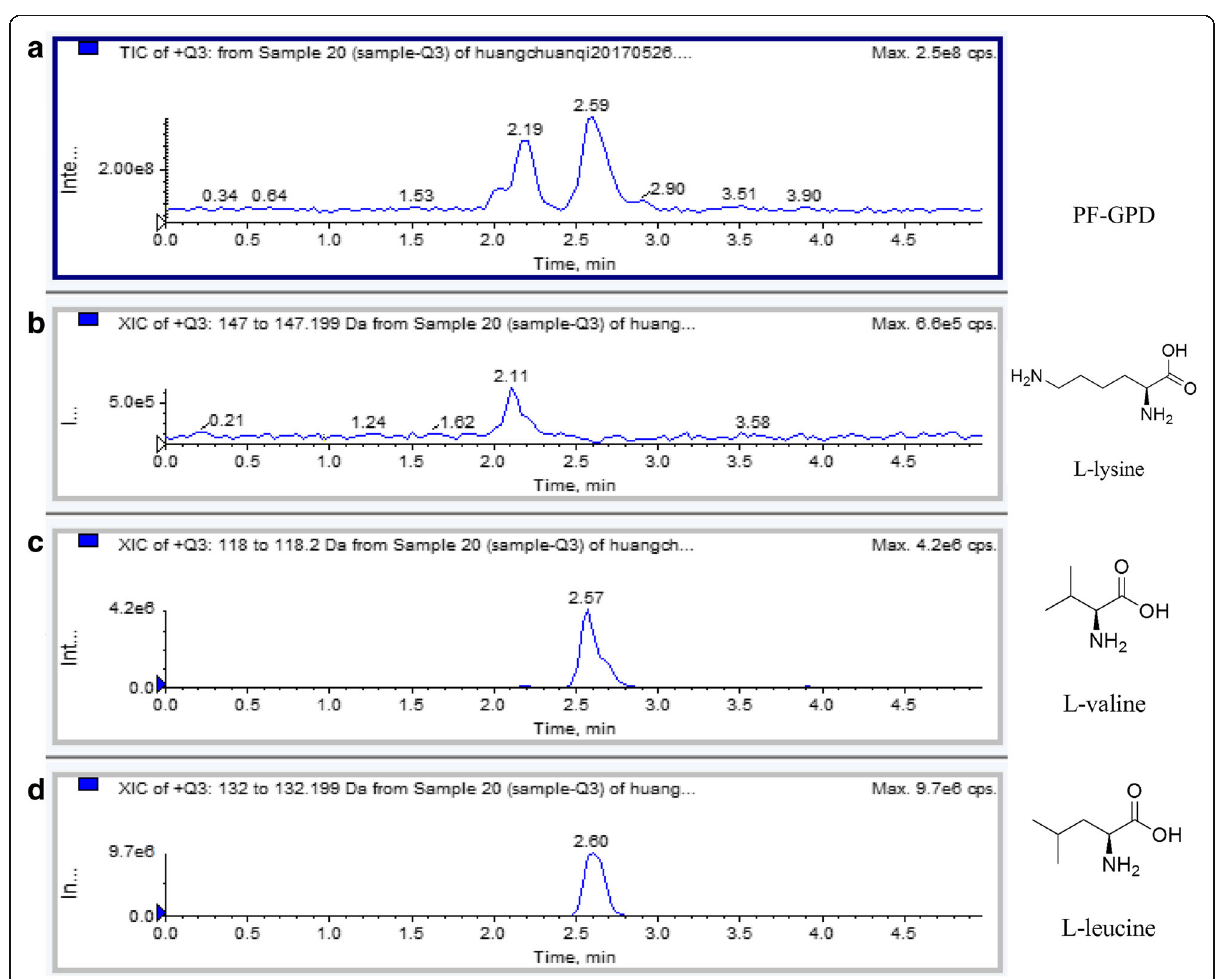
Fig. 1 The effect of GPD and PF-GPD on RAW264.7 cells viability was investigated by MTT assay at various concentrations (5 – 320 μ g/mL) in the absence ( a and c ) or presence ( b and d ) of 1 μ g/mL of LPS. Data was analyzed and expressed as mean±SEM. Statistical significance of the differences were performed by one-way ANOVA for multiple comparisons followed by the LSD test for comparisons between groups. * P < 0.05, ** P < 0.01 compared with